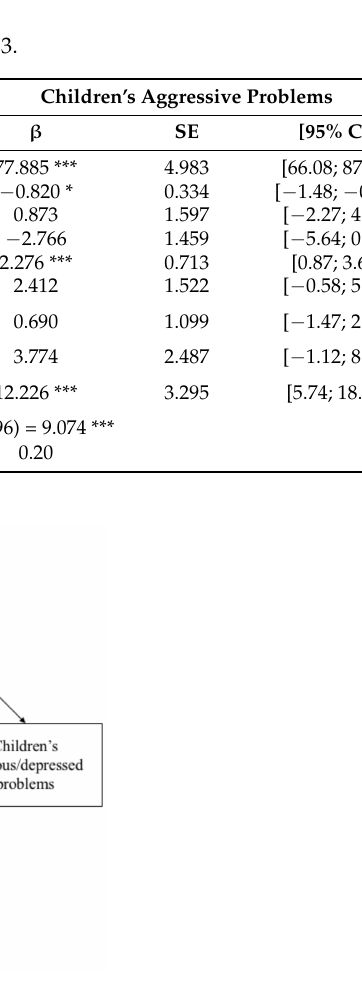
Figure 2. Results of the Moderation Mediated Model 1. Note: * p < 0.05; ** p < 0.01; *** p < 0.001. Only significant path coefficients are displayed; not significant paths were displayed by dotted lines. The covariates are not displayed here, but they were estimated in the model. Analyzing the moderation, the main effect of maternal hypermentalization on chil- dren’s anxious/depressed problems was positive and significant ( β = 3.212; p < 0.001), as well as its main effect on maternal distress ( β = 0.221; p < 0.001). The interaction between COVID-19 exposure and maternal hypermentalization on children’s outcome was negative and significant ( β = − 1.08, p = 0.04), whereas the others were